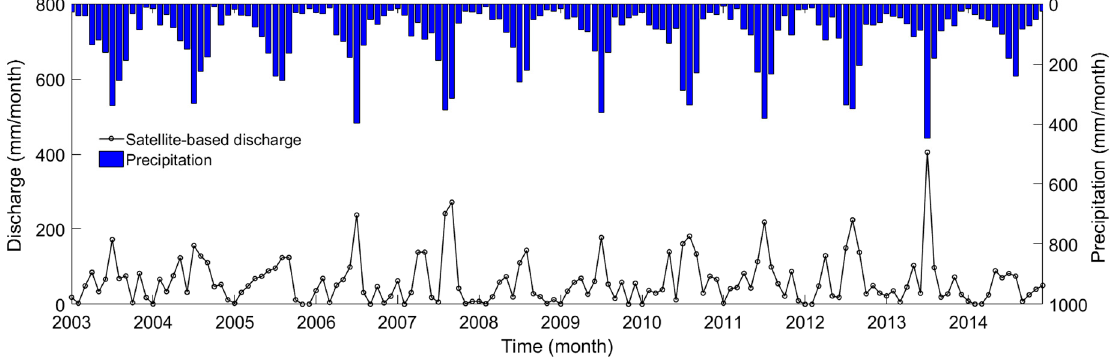
Figure 6. Time series of the satellite-based discharge and precipitation over the Korean Peninsula.